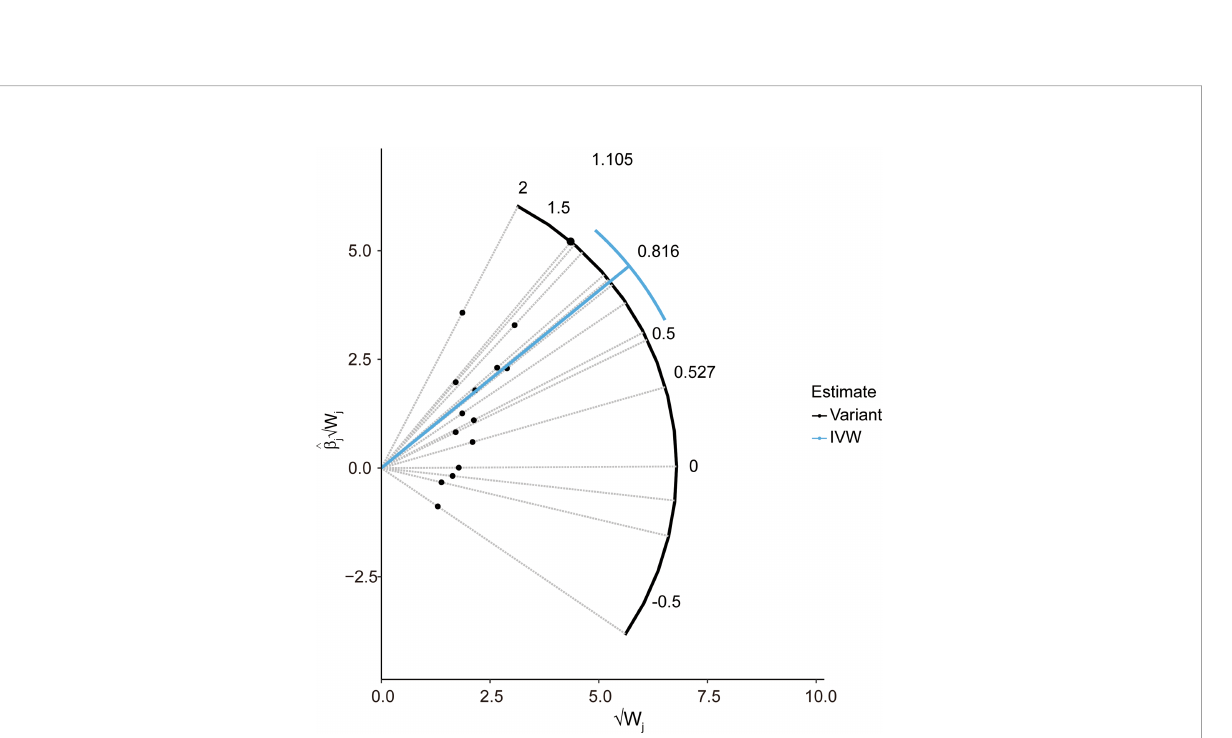
FIGURE 4 Radial plot to illustrate each individual outlier SNPs for the effect of LTL on MS risk. The radial curve demonstrates the estimated ratio for each individual SNP, as well as the overall IVW estimate (in blue). Black dots indicate valid SNPs. IVW, inverse variance weighted method; SNP, single- nucleotide polymorphism; MR, Mendelian randomization; MS, multiple sclerosis; LTL, leukocyte telomere